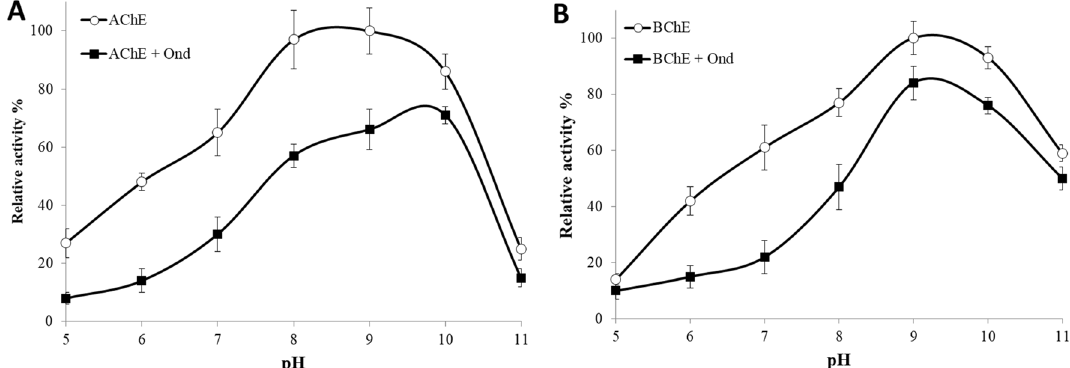
Figure 8. Effect Ondansetron binding at different pH, on the activity of ( A ) AChE and ( B ) BChE. The final concentration of the drug was 21